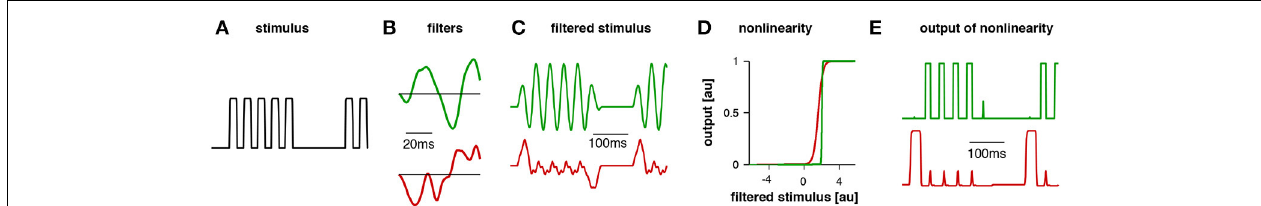
FIGURE 2 | Example traces for the model for Gryllus bimaculatus . The stimulus (A) had a pulse period of 40ms (chirp duration 200ms, chirp period 500ms). The first filter ( B , green) exhibited a pulse period of 40ms and responded well to the pattern ( C , green). The second filter’s dominant modulation was relatively slow; accordingly, it responded poorly to this stimulus ( C , red). For the computation of the filtered stimulus the filter (B) is first aligned with the beginning of the stimulus (A) and then multiplied with the amplitude values of the stimulus over the duration of the filter. The result is a product as a single point in time that reflects the similarity of the filter with the stimulus, high values indicating high similarity. The filter is then